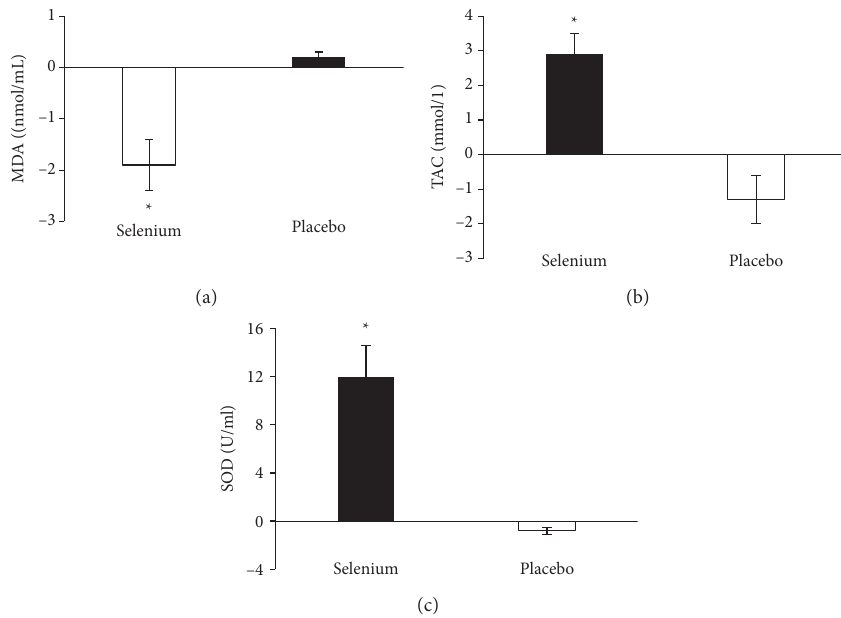
Figure 2: Comparison of the changes ( Δ ) of oxidative stress markers within the two groups. A paired-samples t -test was used to determine the changes from post- to pretreatment (post-pre). (a) Plasma MDA levels (nmol/ml). (b) Plasma TAC activity (mmol/l). (c) Plasma SOD activity (U/ml). The data were shown as standard deviation. ∗ P < 0 .